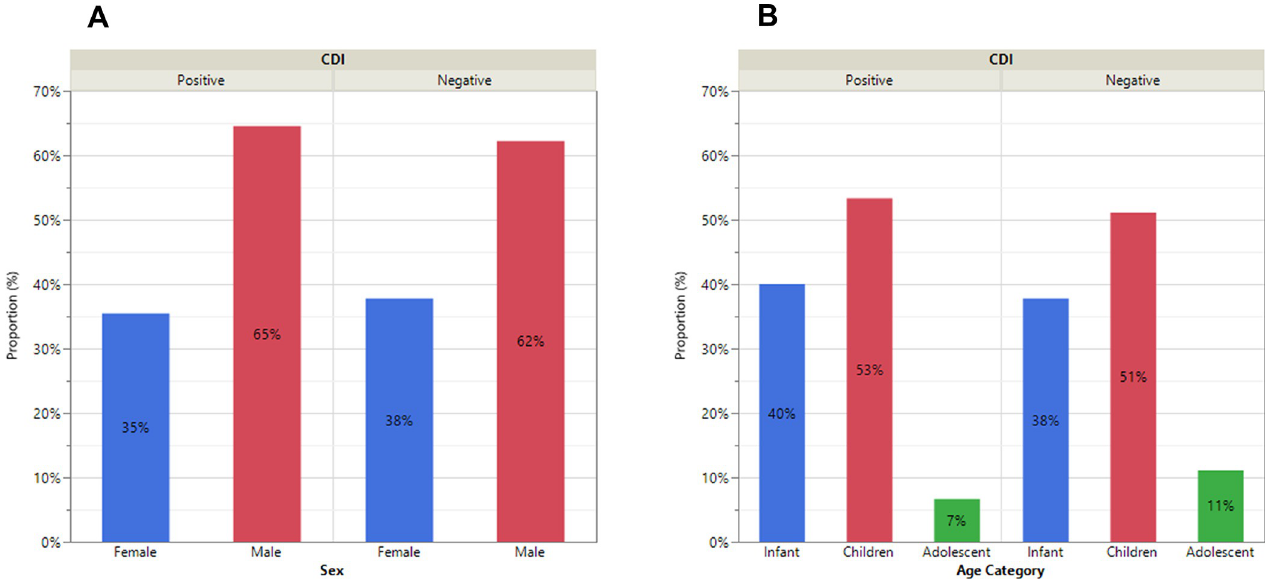
Fig 1. Distribution of the presence of C . difficile in the stools of pediatric patients with diarrhea by sex (A) and age (B).